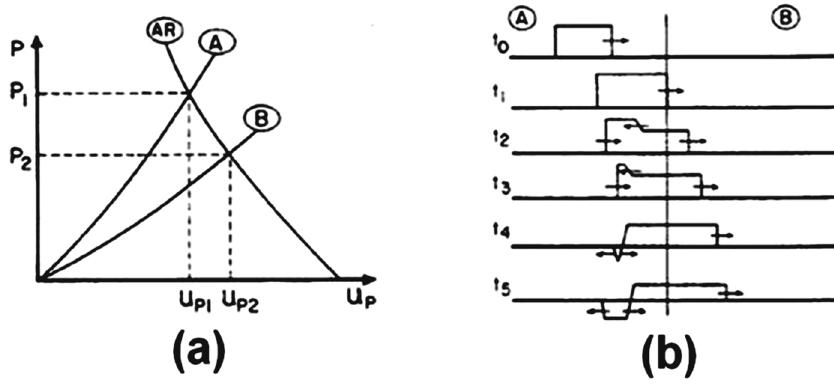
Figure 1. Transmission of shock wave from a medium with high to another with low density: ( a ) pressure-particle velocity plots; ( b ) stress profiles.